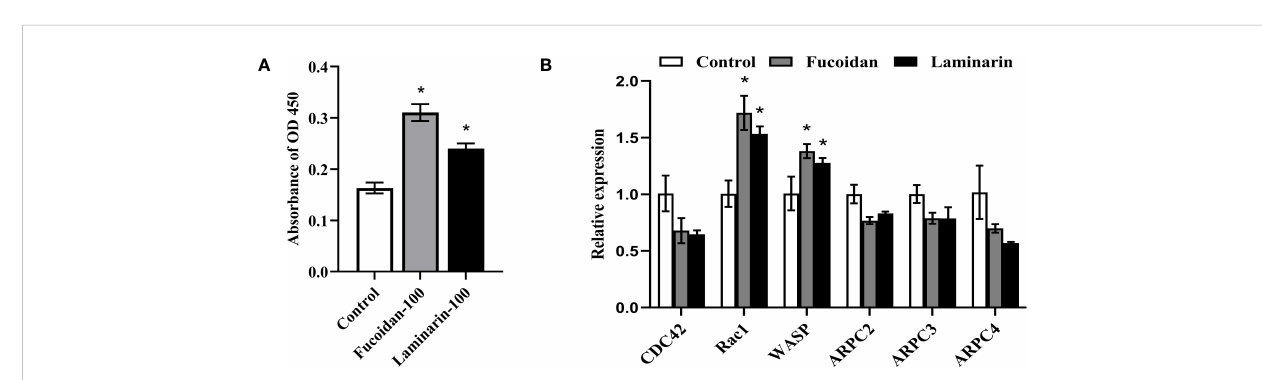
FIGURE 4 Fucoidan and laminarin bind with MaINTL and regulate the expression of candidate signaling molecules involved in the phagocytosis of macrophages. (A) 96-well plates were pre-coated with fucoidan (100 mg/mL) and laminarin (100 mg/mL), and their binding with MaINTL was detected by the absorbance at OD450 nm. Asterisks indicate signi fi cant variations (P < 0.05). (B) Fucoidan (100 mg/mL) and laminarin (100 mg/mL) stimulate the expression of signaling molecules that might be involved in the phagocytosis. Asterisks denoted signi fi cant differences (P <